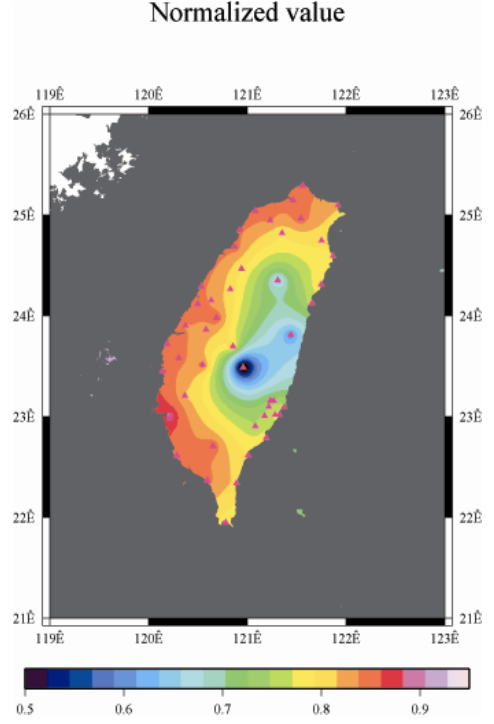
Figure 12. Normalized ZTD values around the island after the typhoon struck Taiwan (September 15th, 2008, 9:00